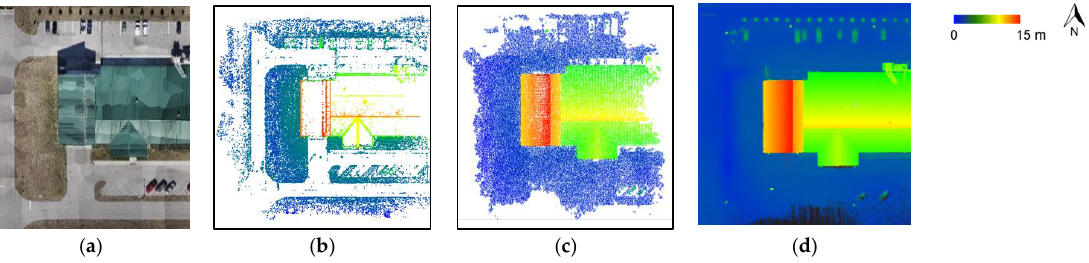
Figure 5. Generated orthophoto and point clouds (colored by height) for the A-1 dataset: ( a ) orthophoto, ( b ) image-based sparse point cloud with 20,000 points, ( c ) image-based dense point cloud with 80,000 points, and ( d ) LiDAR point cloud with 31,000,000